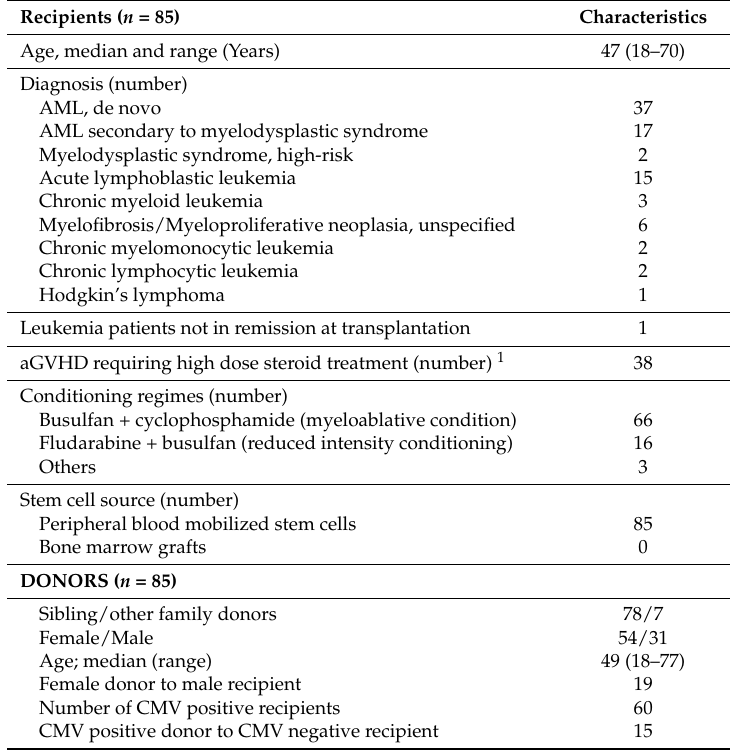
Table 5. The characteristics of the allotransplant recipients and their donors included in the